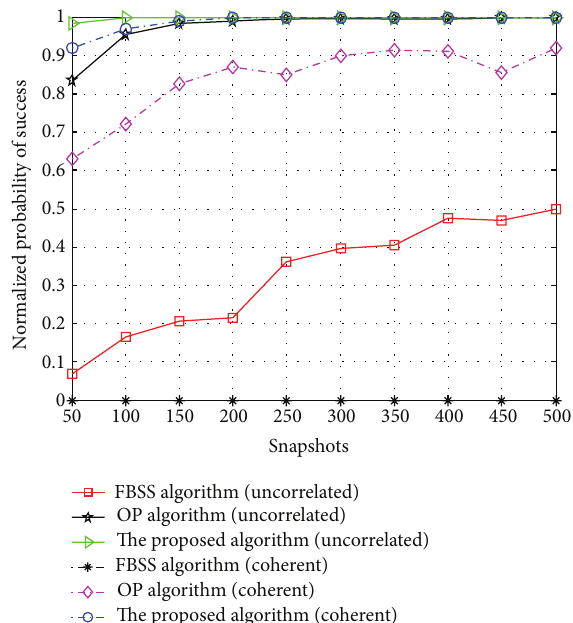
Figure 4: RMSE of the DOA estimates versus input snapshots for the uncorrelated and coherent signals.